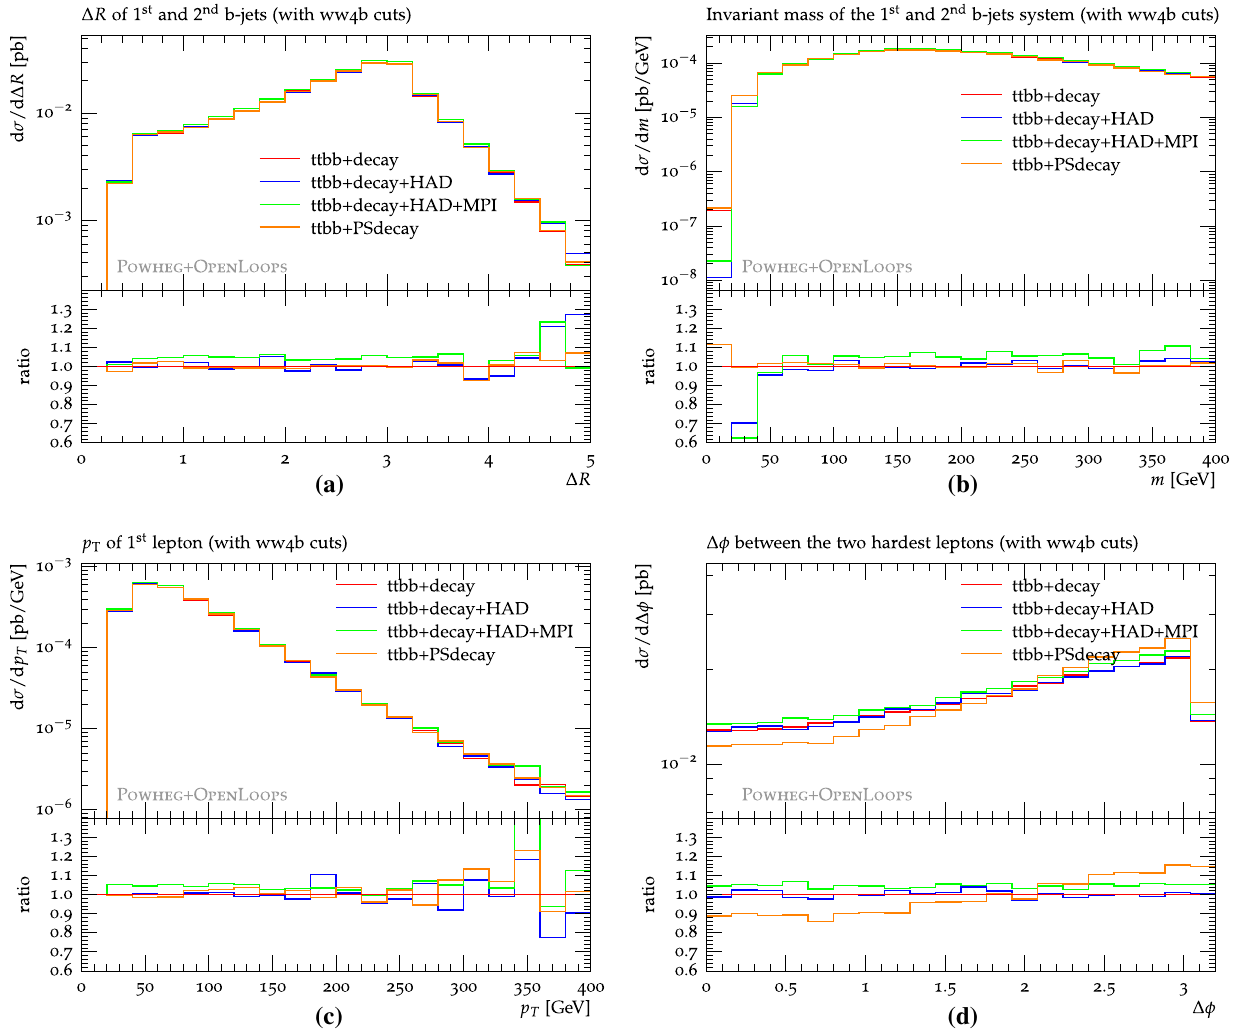
Fig. 15 Distributions in the invariant mass ( a ) and Δ R ( b ) of the first and second b -jet, in the p T of the leading lepton ( c ), and in the azimuthal Δφ separation of the two charged leptons ( d ). Predictions and ratios as in Fig.